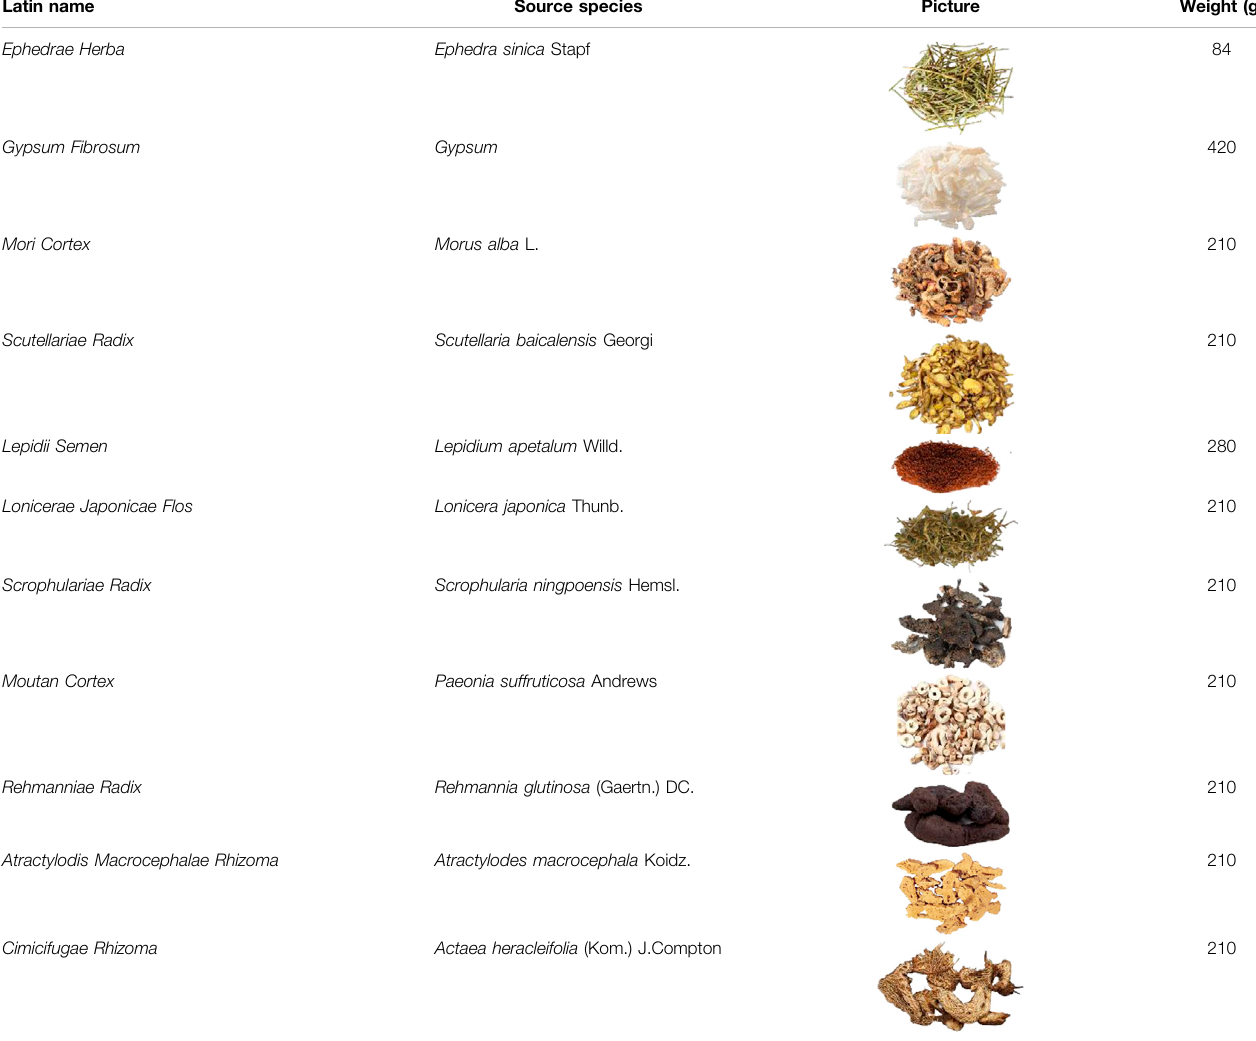
TABLE 1 | The ingredients contained in YDJDG.